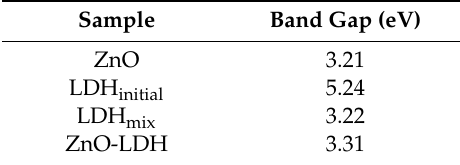
Table 5. Band gap energy of the components and hybrid structure.